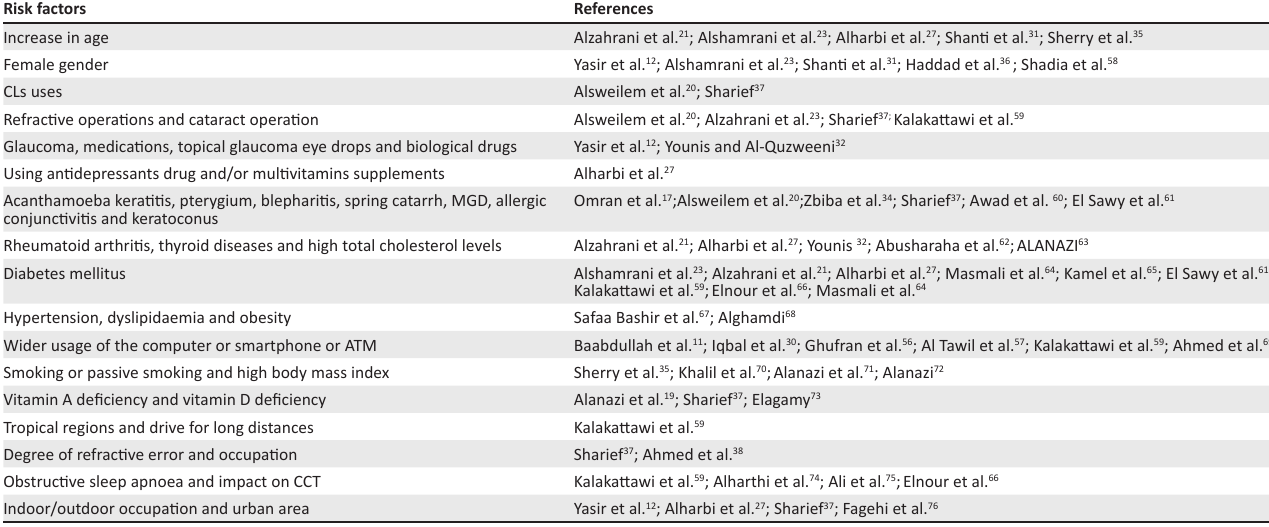
TABLE 2: Risk factors associated with dry eyes amongst the Arab population from 2017 to